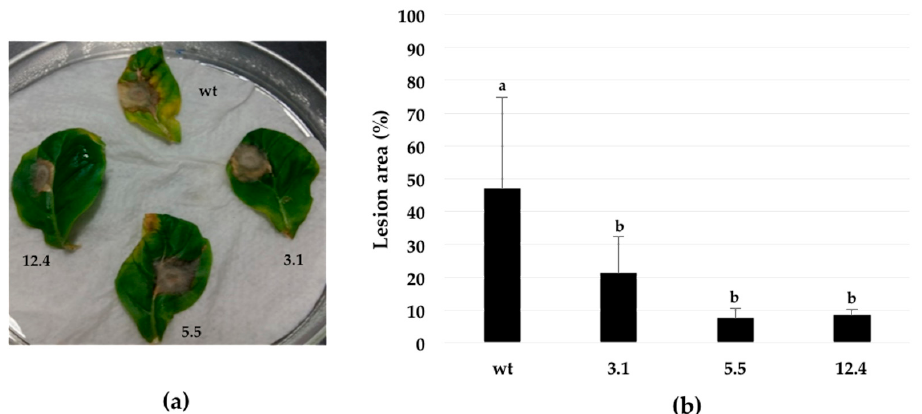
Figure 6. Resistance assay against phytopathogenic fungus B. cinerea . ( a ) Phenotype of transgenic plants after inoculation with mycelium of B. cinerea during 7 days. ( b ) Percentage of area leaf infection in control and transformed tobacco lines. Leaf damage by B. cinerea infection was significantly different from the control with a value at p < 0.0001. Different letters indicate statistically significant differences. Error bars indicate standard deviation of means (SD). Three independent replicates were performed for each experiment.